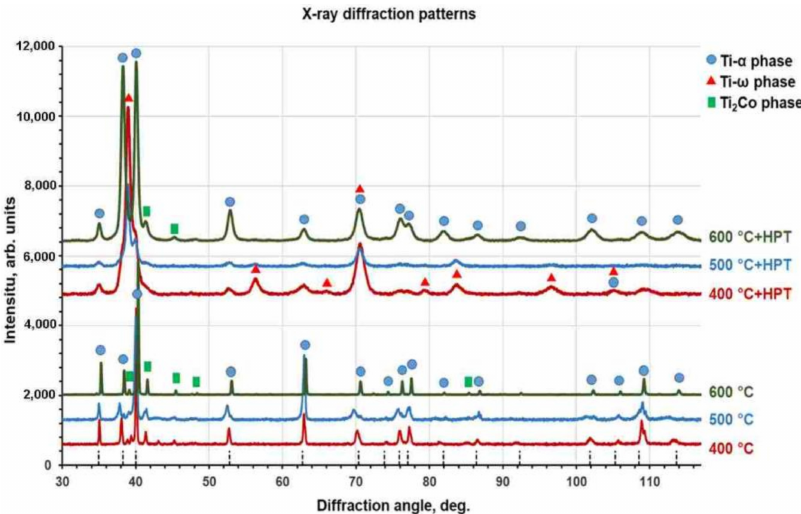
Figure 2. X-ray diffraction patterns for Ti–4 wt.% Co alloy after annealing at 400, 500 and 600 ◦ C (lower patterns) and after high pressure torsion (HPT) with preliminary heat treatment (upper patterns). Vertical dotted lines show the positions of the reflections for pure α